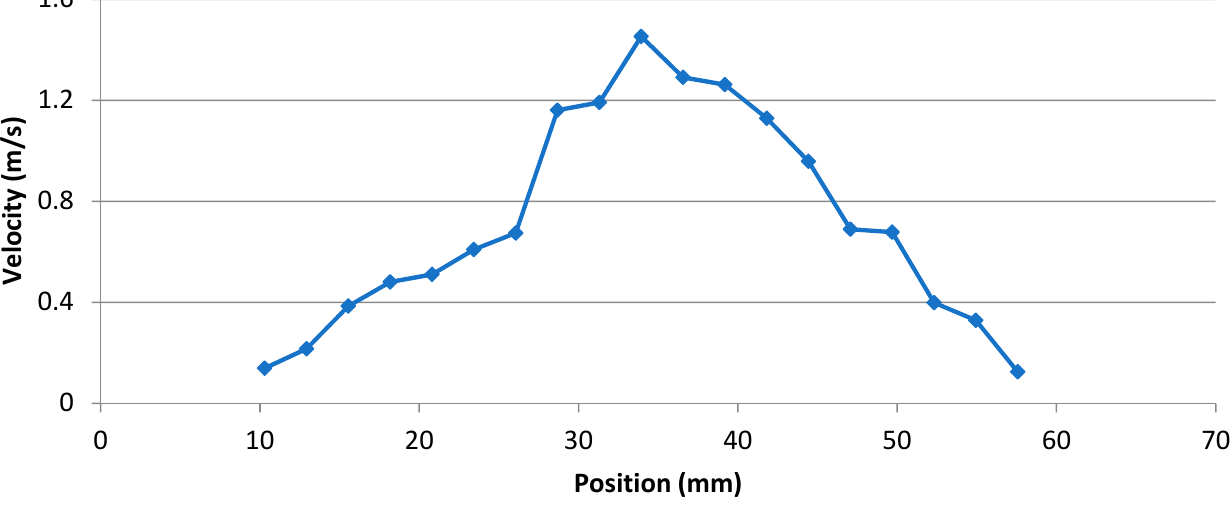
Figure 10. Flow velocity profile acquired from measured PIV data.